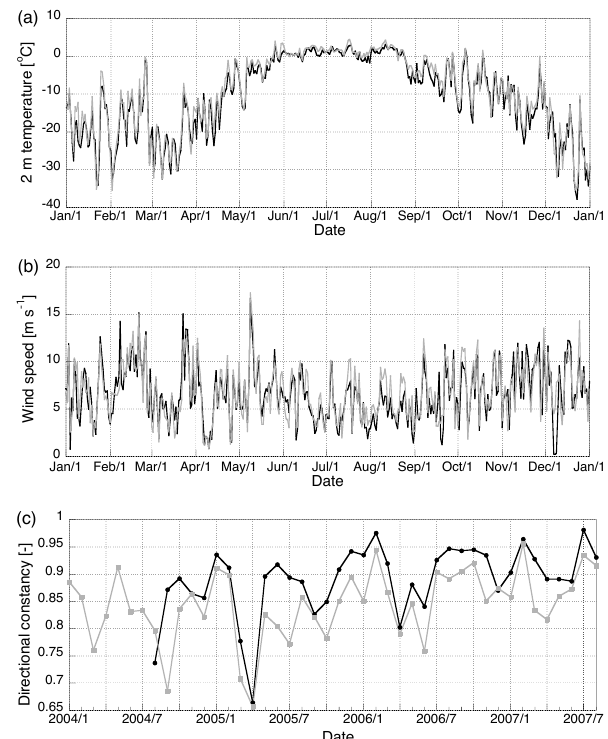
Fig. 6. Comparison of simulated (gray lines) and observed (black lines) daily averaged (a) 2m temperature [ ◦ C], (b) 10m wind speed [ms − 1 ] at S6 for the year 2004, and (c) comparison of simulated (gray lines) and observed (black lines) monthly averaged directional constancy [ − ] of 10m wind at S6 for the period January 2004– August 2007.